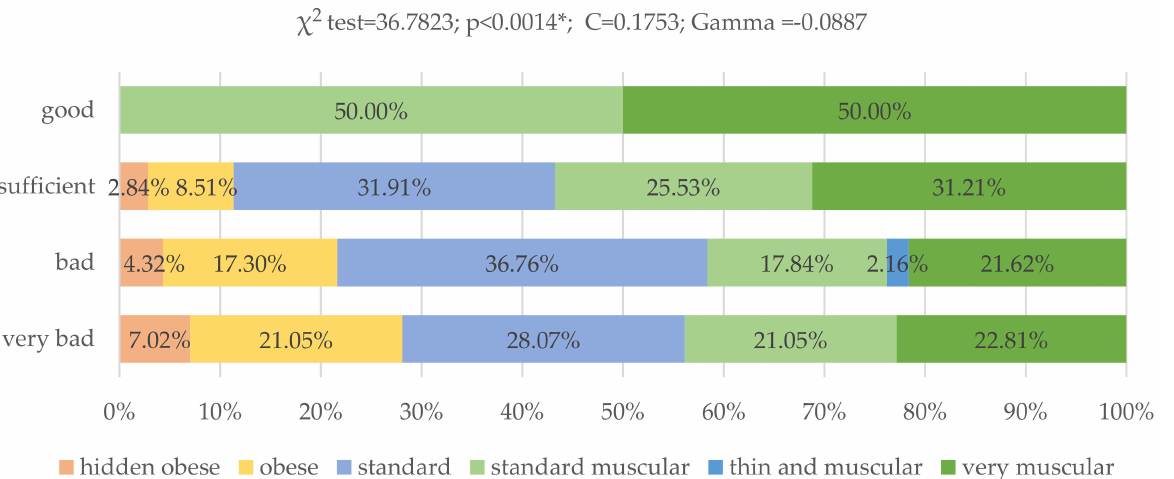
Figure 9. Assessment evaluation of the nutritional behavior of young Poles and their physique physical rating ( N = 399). Age and sex of the respondents were taken into account when assessing body type. The study group did not include people with the following body types: solidly-built, under exercised, thin. * Statistically significant differences ( p < 0.05). Source: own study based on the